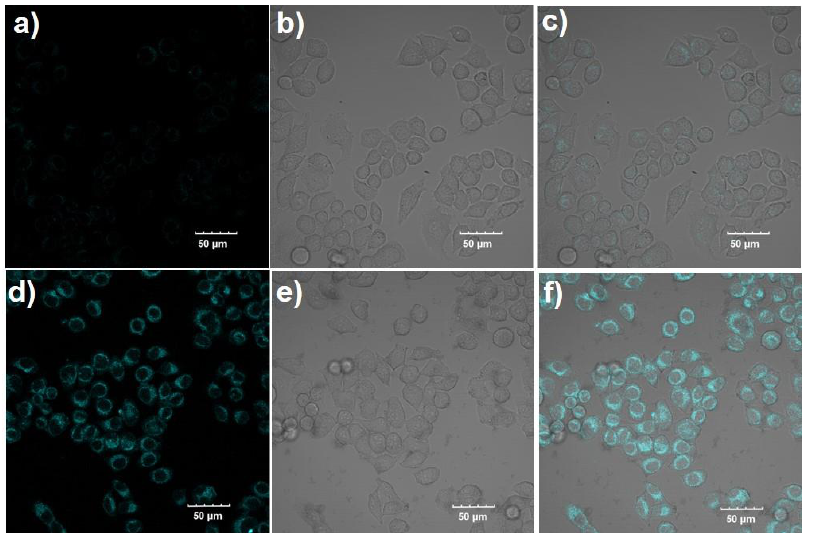
in Hela cells was measured. It could be seen that the fluorescence intensity was en-